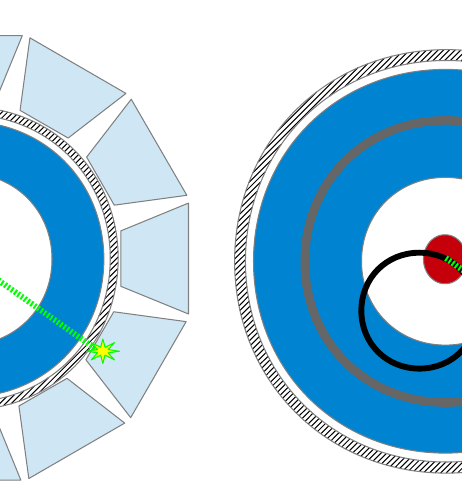
trackingdetector(darkblue),photons(ingreen)eitherproduceashower in a calorimeter (light blue) or are converted by a thin layer of high- Z material (in gray) into an electron-positron pair (in red and black, respectively) which is then reconstructed by an outer tracking detector. The magnet coil (hatched area) surrounds the tracking